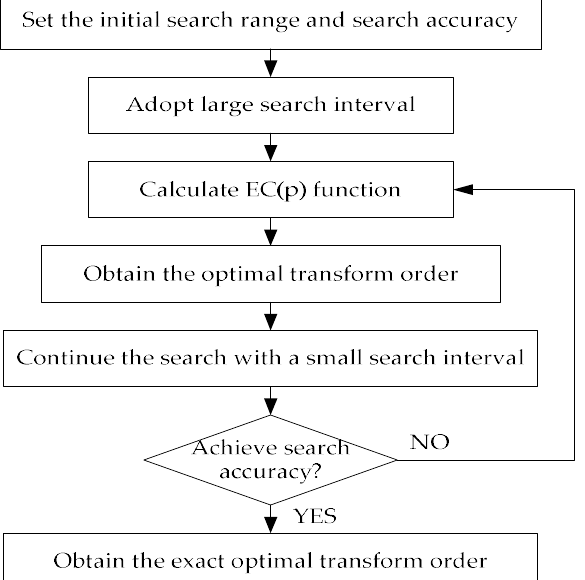
Figure 5. Optimal order search flow chart.